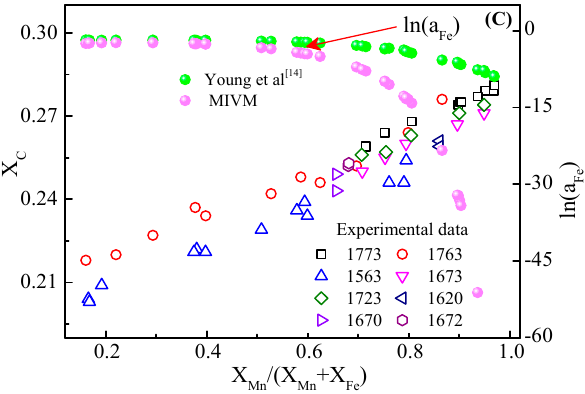
Figure 6. Mn ( A ), Fe ( B ), and C ( C ) activity calculated at different proportions of X Mn /(X Mn + X Fe ) in Mn–Fe–C liquid alloys in equilibrium with graphite at various temperatures; experimental data were sourced from [7,8,27–31,34].